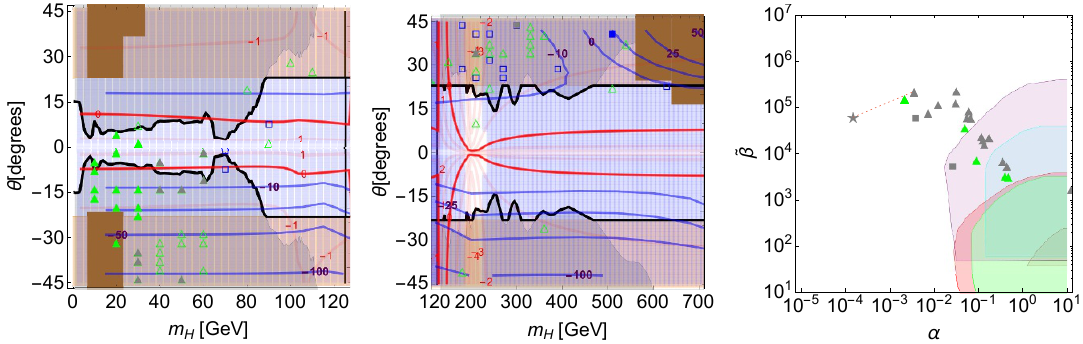
Figure 6 . Types of multi-step PT for m X = 100 GeV, g X = 0 . 5 ( v S = 200 GeV). See the captions of figures